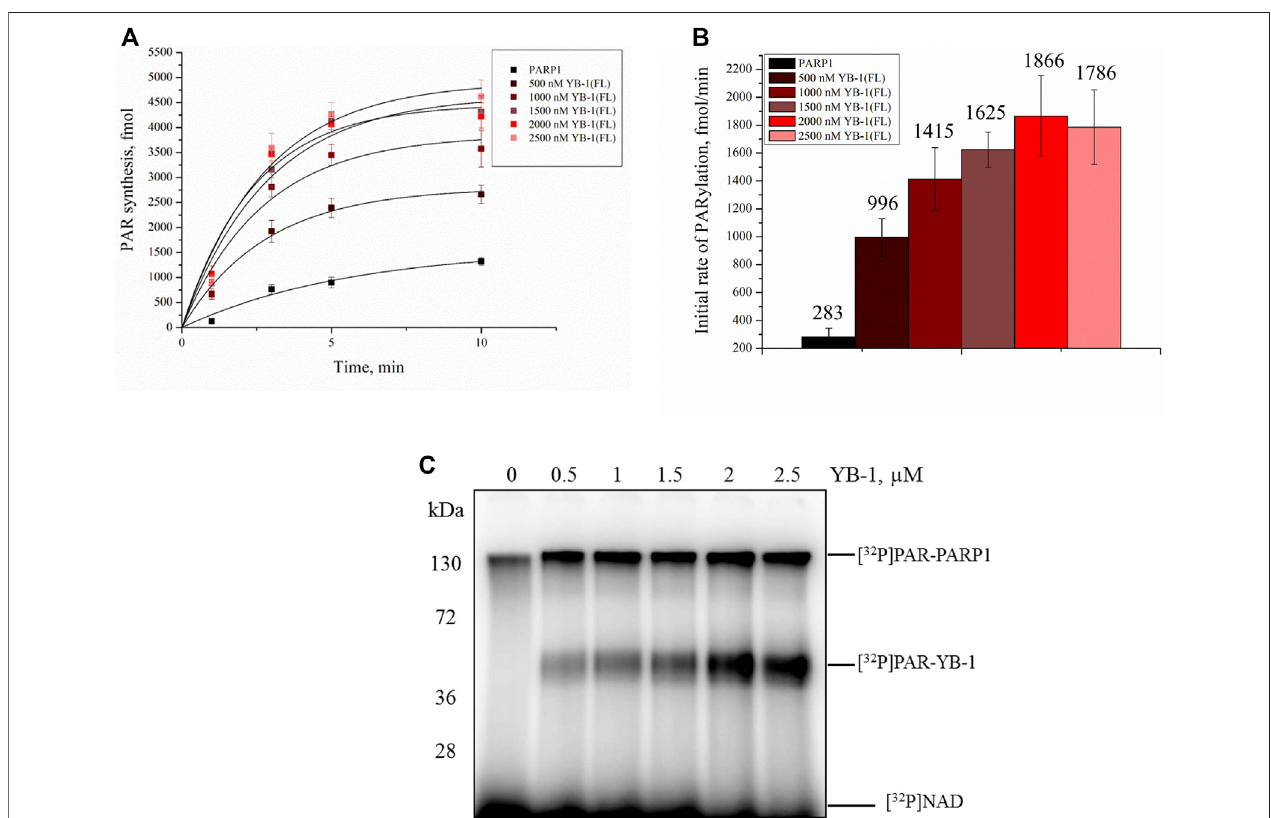
FIGURE 4 | YB-1 increases the rate of PAR synthesis by PARP-1 and the PARylation level of protein targets (PARP-1 and YB-1). (A) Kinetics of PAR synthesis catalyzed by PARP1 in the absence or presence of various concentrations of YB-1(FL). Graphs represent the mean values of three independent experiments with error bars representing ± SD. (B) Initial rates of PAR synthesis estimated in the presence of various concentrations of YB-1(FL). PARP1 at 100 nM was incubated with 0.5 OD 260 /ml DNA act , 20 μ M NAD + , and [ 32 P]NAD (0.4 μ Ci) in the presence of 0.5 – 2.5 µM YB-1(FL) as indicated. [ 32 P]PAR-modi fi ed proteins were precipitated with TCA and quanti fi ed radiographically. The initialrates(fmol/min)were determined from a direct analysisof progressive curve (A) which yields P max and k (Equations 1and